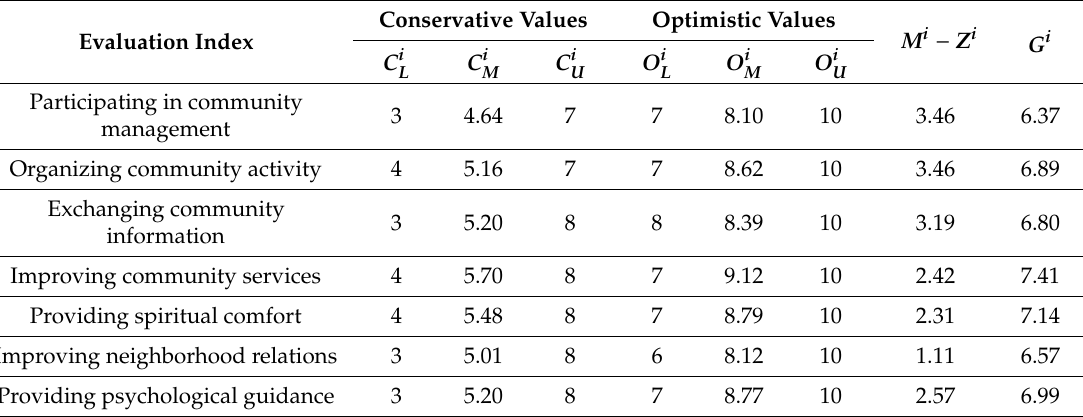
Table 8. Fuzzy Delphi expert questionnaire results (round